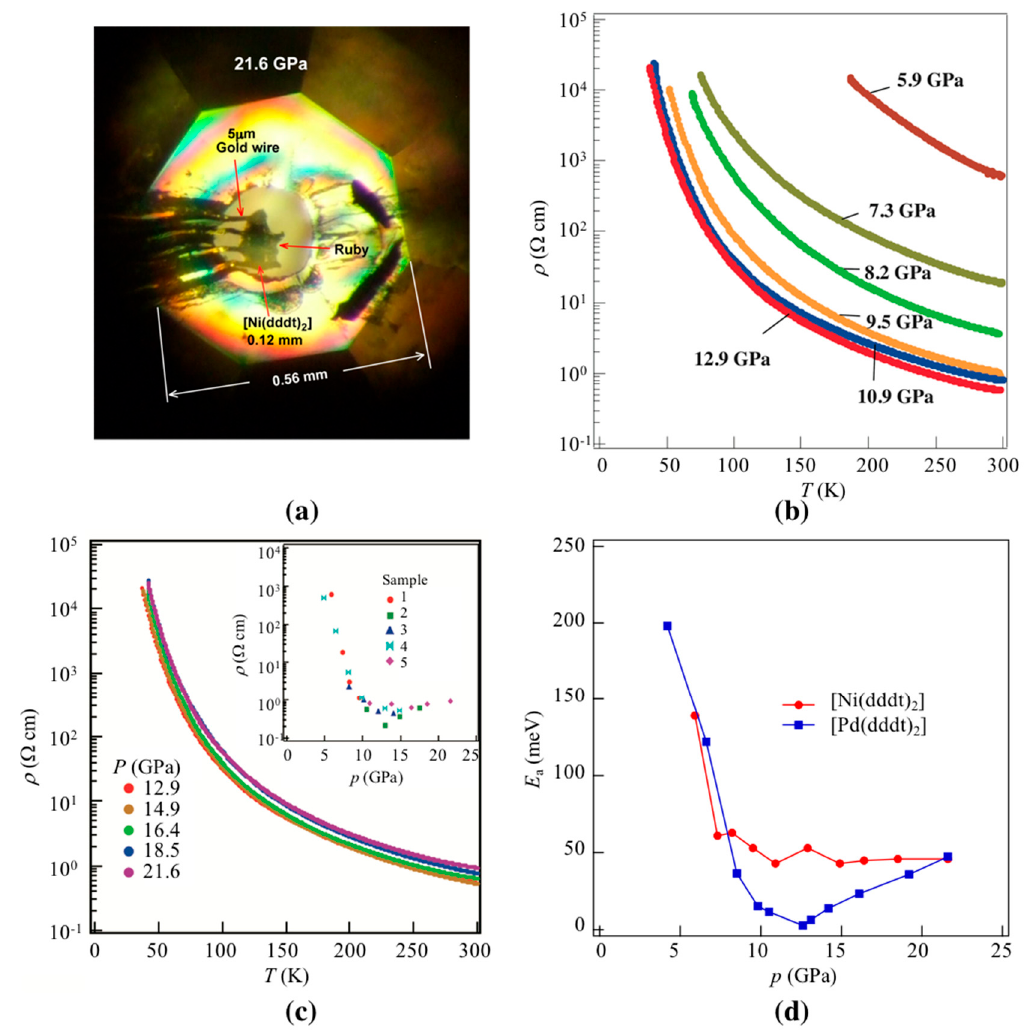
Figure 2. ( a ) Optical microscope image of the [Ni(dddt) 2 ] sample at 21.6 GPa assembled in a Diamond Anvil Cell (DAC). ( b ) and ( c ) Temperature-dependent resistivity, ρ , under various pressures; inset in ( c ) shows the pressure dependence of room temperature resistivity. ( d ) Pressure dependence of activation energy, E a , showing data for [Pd(dddt) 2 ] for comparison.